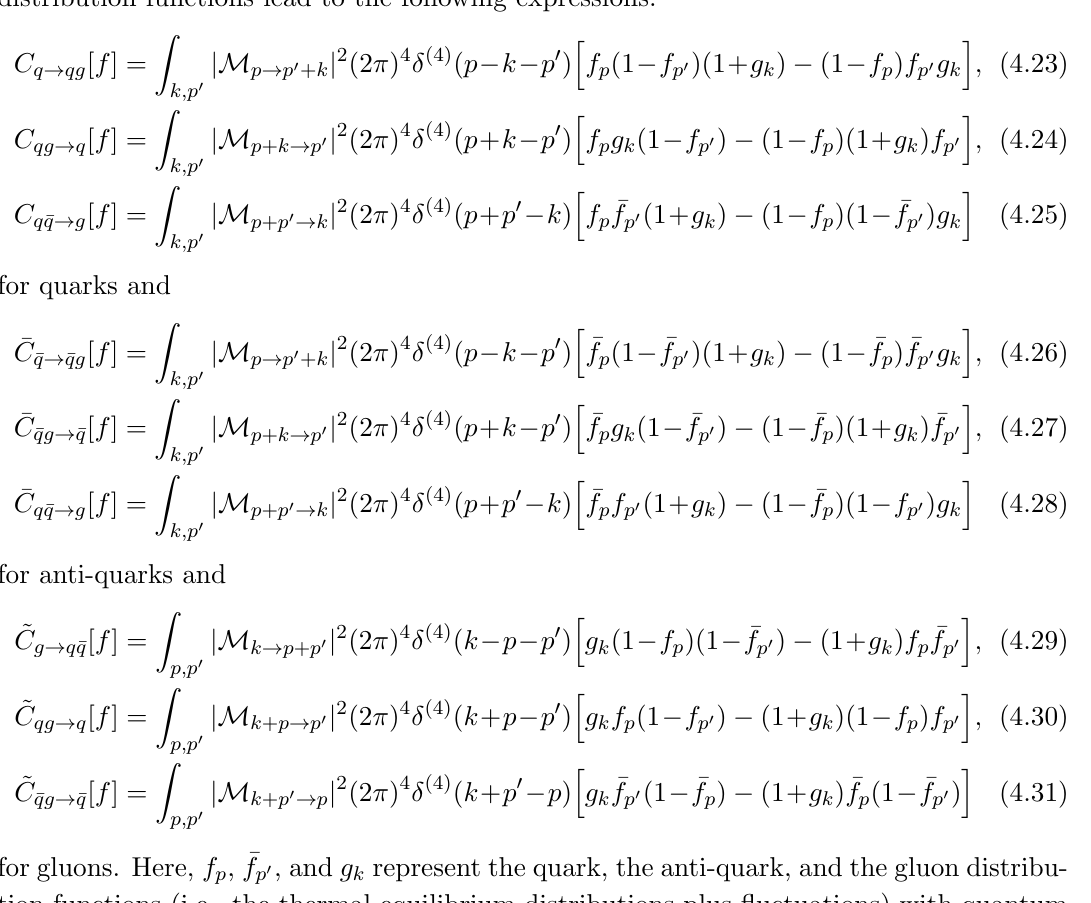
Figure 4 . Diagrams of the radiation process with a quark (a1) and a anti-quark (b1), the pair annihilation (c1), and their inverse processes, (a2), (b2), and (c2). distribution functions lead to the following